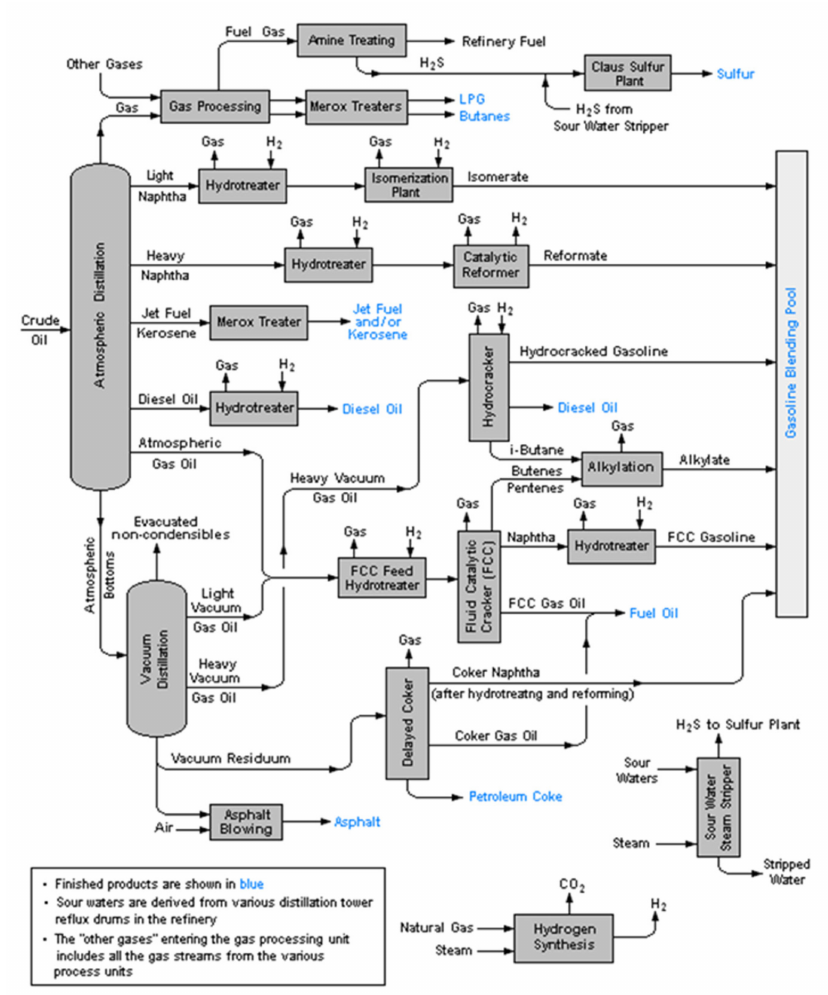
Figure 1. From Wikimedia Commons, the free media repository https://commons.wikimedia.org/ wiki/File:RefineryFlow.png (accessed on 2 April 2022). Permission is granted to copy,